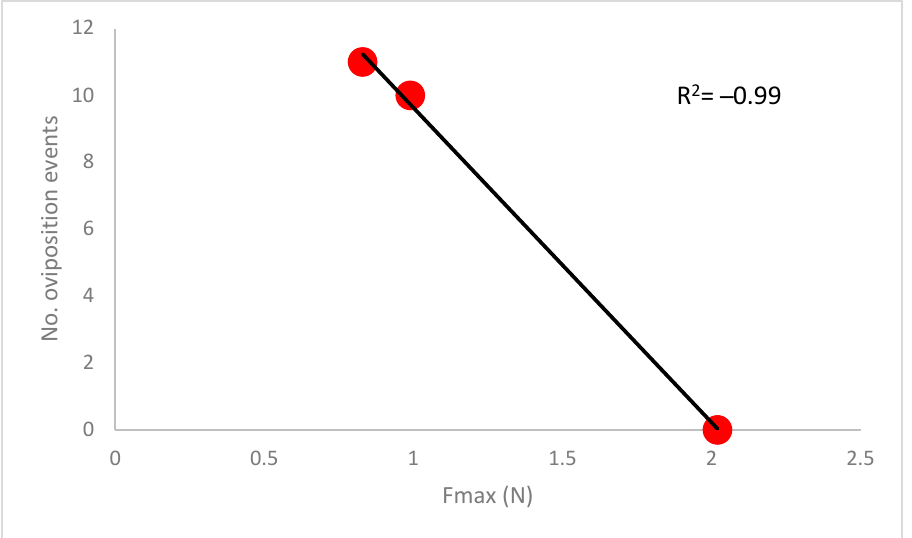
Figure 5. Number of oviposition events recorded in the oviposition trials (N = 50 galls per month) in relation to the toughness of the galls expressed as maximum force (Fmax).